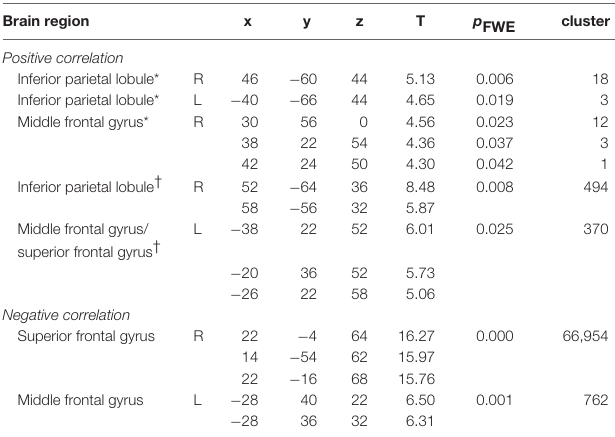
TABLE 1 | Brain regions correlated with TTLC.